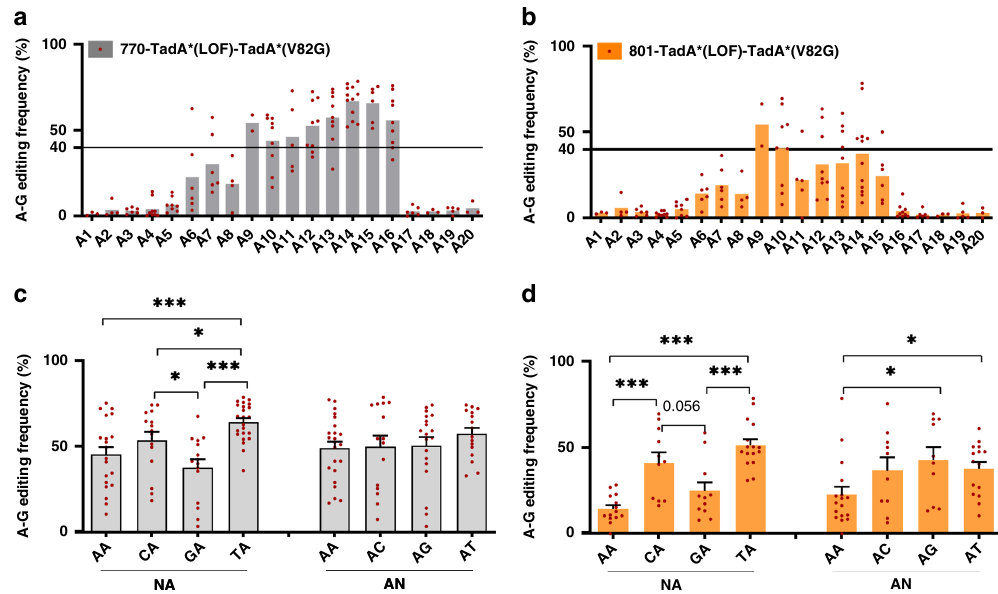
Fig. 5 Comprehensive analysis of editing windows and sequence preference for 770- and 801-TadA* (LOF)-TadA* (V82G). a , b A – G conversion frequencies at each adenine position across 20 sgRNA sites were quanti fi ed and summarized for 770- TadA* (LOF)-TadA* (V82G) ( a ) and 801-TadA* (LOF)-TadA* (V82G) ( b ). Dot plots in the fi gure are averages of n = 2 biologically independent experiments. c , d Sequence preference was analyzed for 770- TadA* (LOF)-TadA* (V82G) ( c ) and 801-TadA* (LOF)-TadA* (V82G) ( d ). * p < 0.05, *** p < 0.001; **** p < 0.0001 with two-tailed unpaired t-test. Dot plots in the fi gure are averages of n = 2 biologically independent experiments. Data here are represented as mean with S.E.M. of all dot plots in the same column. (For 770- TadA* (LOF)-TadA* (V82G), AA vs TA, p = 0.0004; CA vs GA, p = 0.0287; CA vs TA, p = 0.0037; GA vs TA, p < 0.0001. For 801- TadA* (LOF)-TadA* (V82G), AA vs CA, p = 0.0002; AA vs TA, p < 0.0001; CA vs GA, p = 0.0056; GA vs TA, p = 0.0001; AA vs AG, p = 0.0217; AA vs AT, p = 0.0127.) Source data are available in the Source data fi